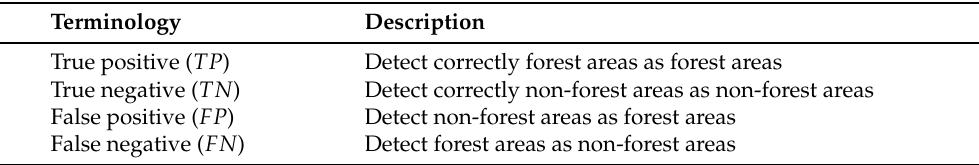
Table 5. Terminology of the confusion